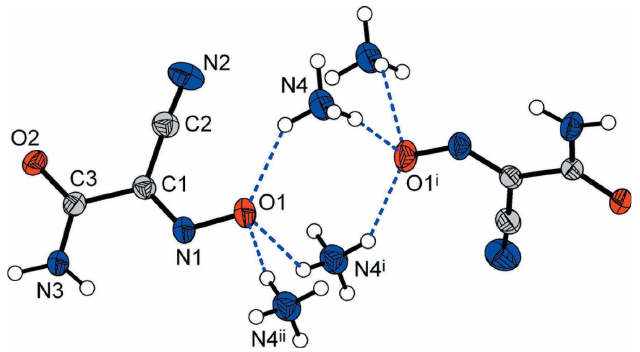
Figure 1 The molecular structure of the title compound with displacement ellipsoids drawn at the 50% probability level. Dotted blue lines indicate N—H (cid:2)(cid:2)(cid:2) O hydrogen bonds [symmetry codes: (i) (cid:3) x , (cid:3) y , z (cid:3) 1 (cid:3) y , z + 1 2